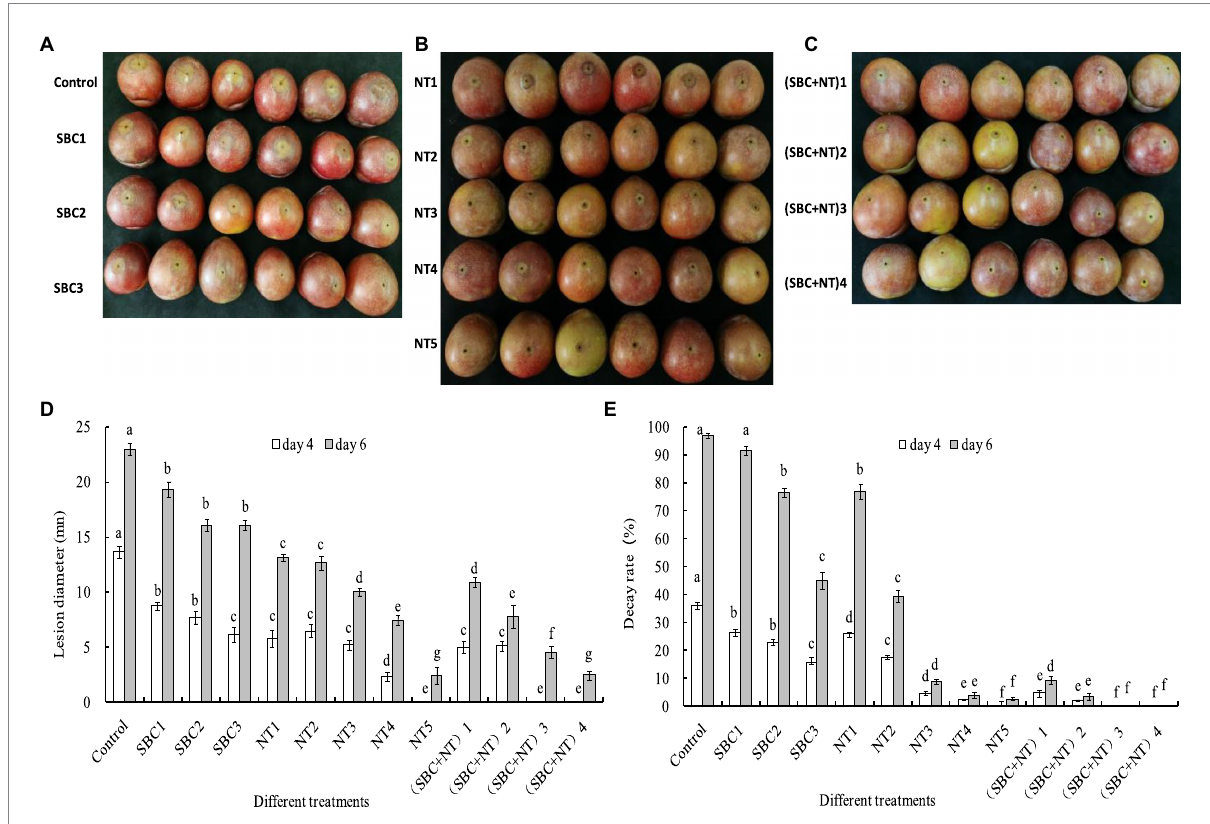
FIGURE 15 SBC or NT inhibits Aspergillus niger virulence on harvested Shengzhou nane fruit. (A) Control and SBC treatments; (B) NT treatments; (C) SBC and NT combined treatments; (D) corresponding histograms for statistical data on lesions on harvested fruit; (E) fruit decay rate. SBC 1 : 2.0 g/L, SBC 2 : 4.0 g/L, SBC 3 : 6.0 g/L, NT 1 : 25.0 mg/L, NT 2 : 50.0 mg/L, NT 3 : 100.0 mg/L, NT 4 : 200.0 mg/L, NT 5 : 400.0 mg/L, (SBC + NT) 1 : 4.0 g/L SBC + 25.0 mg/L NT, (SBC + NT) 2 : 4.0 g/L SBC + 50.0 mg/L NT, (SBC + NT) 3 : 4.0 g/L SBC + 100.0 mg/L NT, (SBC + NT) 4 : (4.0 g/L SBC + 150.0 mg/L NT). ANOVA was employed to compare the mean values of the analysis parameters ( p < 0.05). The results are shown as the mean ± standard deviation ( n = 3). Different superscript letters in the same column indicate significant differences ( p <